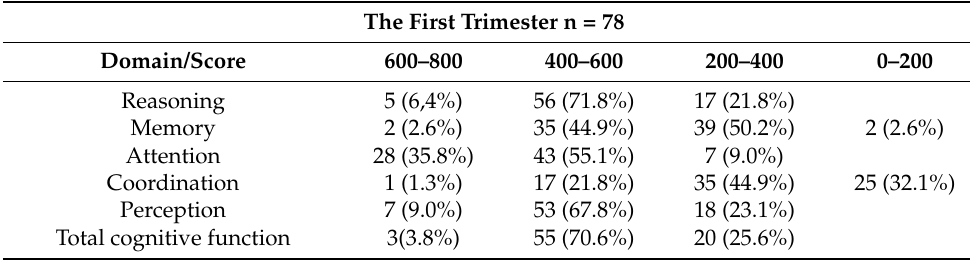
Table 2. Results of the cognitive function test (Cognifit) in the first